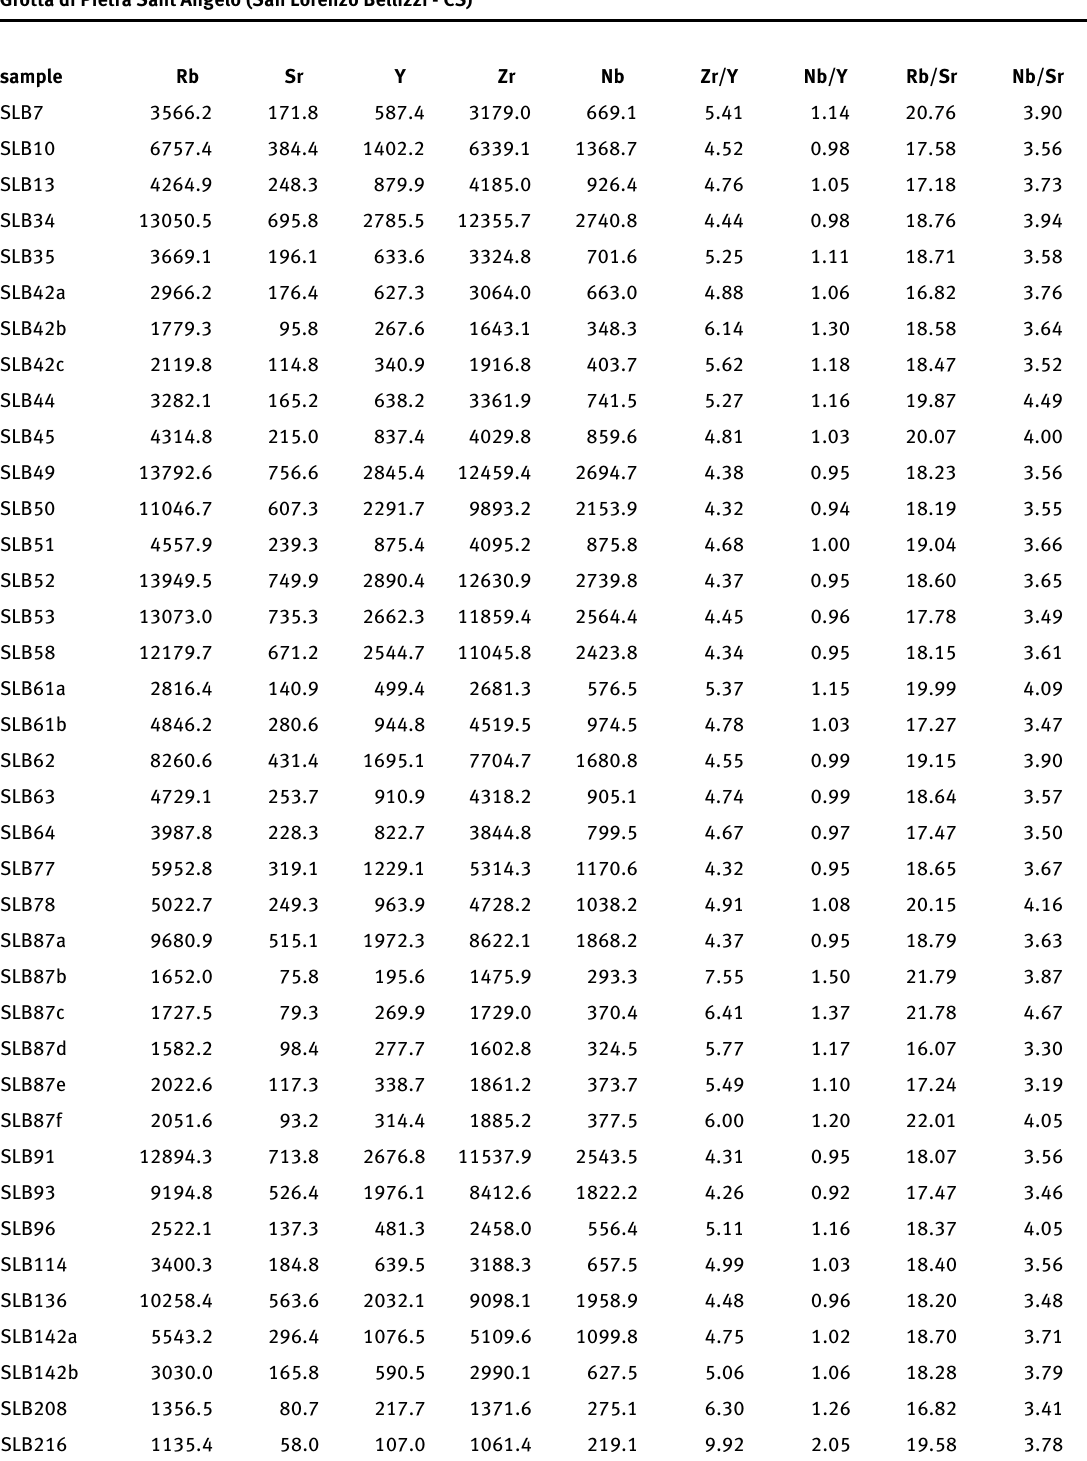
Table 1: WD-XRF detection of X-ray emission of some trace elements of the obsidian artefacts. The X-rays intensity values, expressed as counts per second, are background and interference free. Some characterizing ratios are also